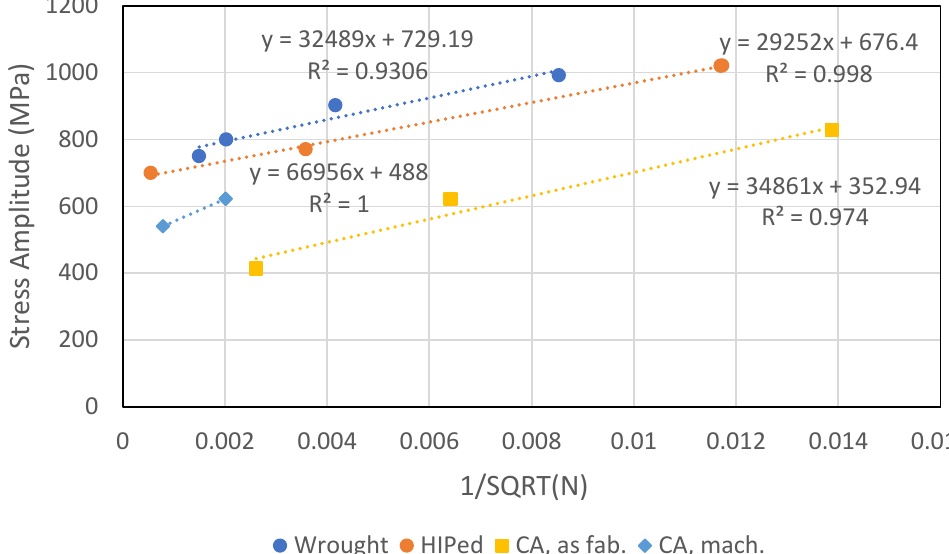
Figure 3. Fatigue strength vs. inverse square root of cycle number.